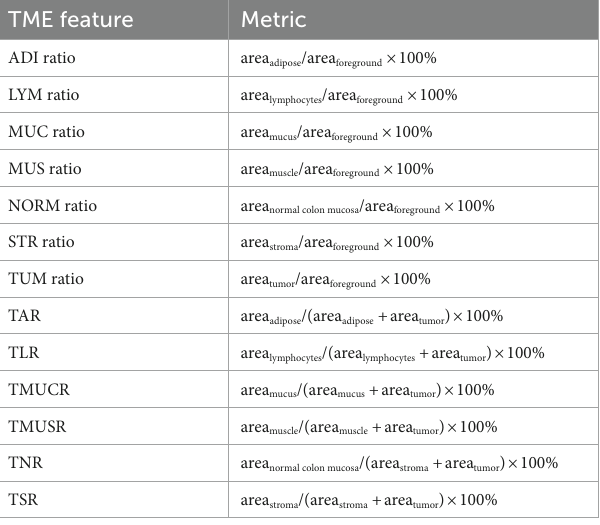
TABLE 1 Metric of TME features in the present